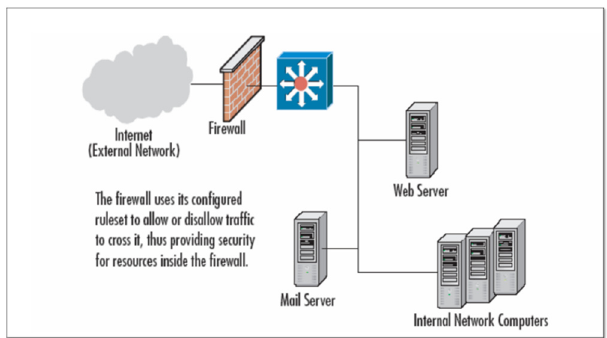
Figure 4. A basic firewall topology (Author’s interpretation of SME business network).